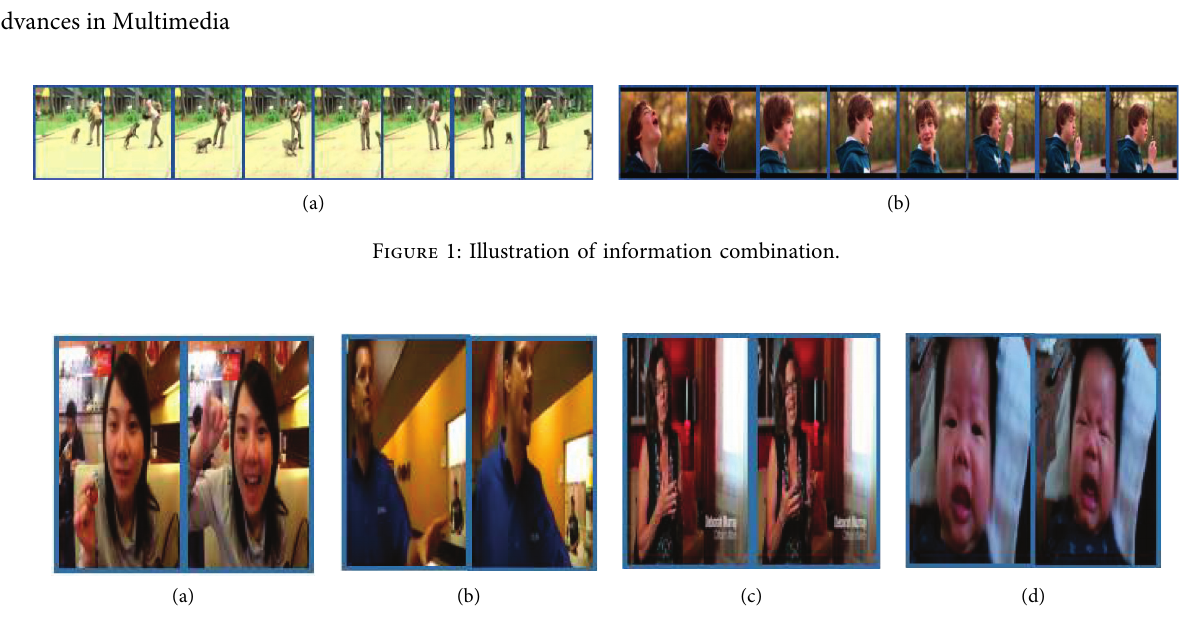
Figure 2: Illustration of emotion